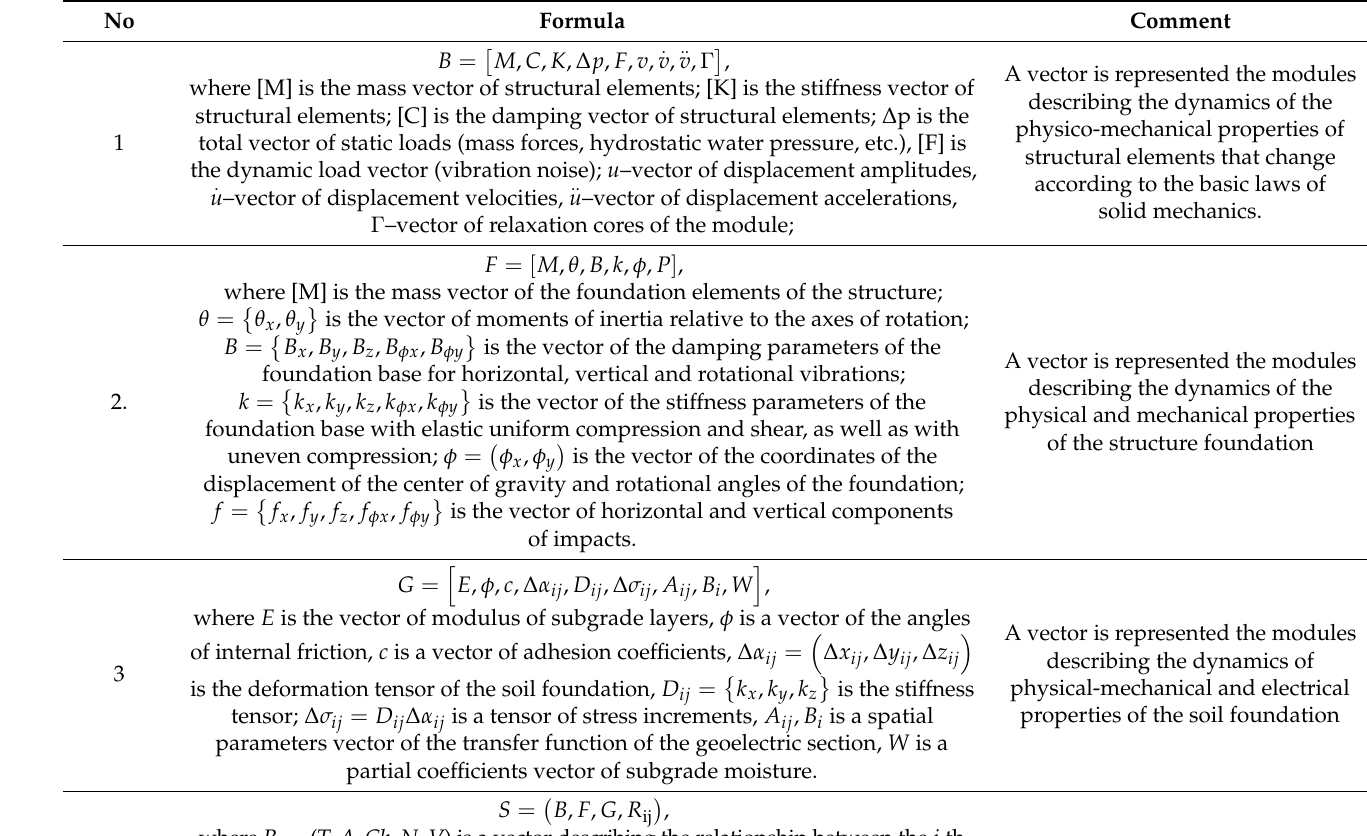
Table 1. The system